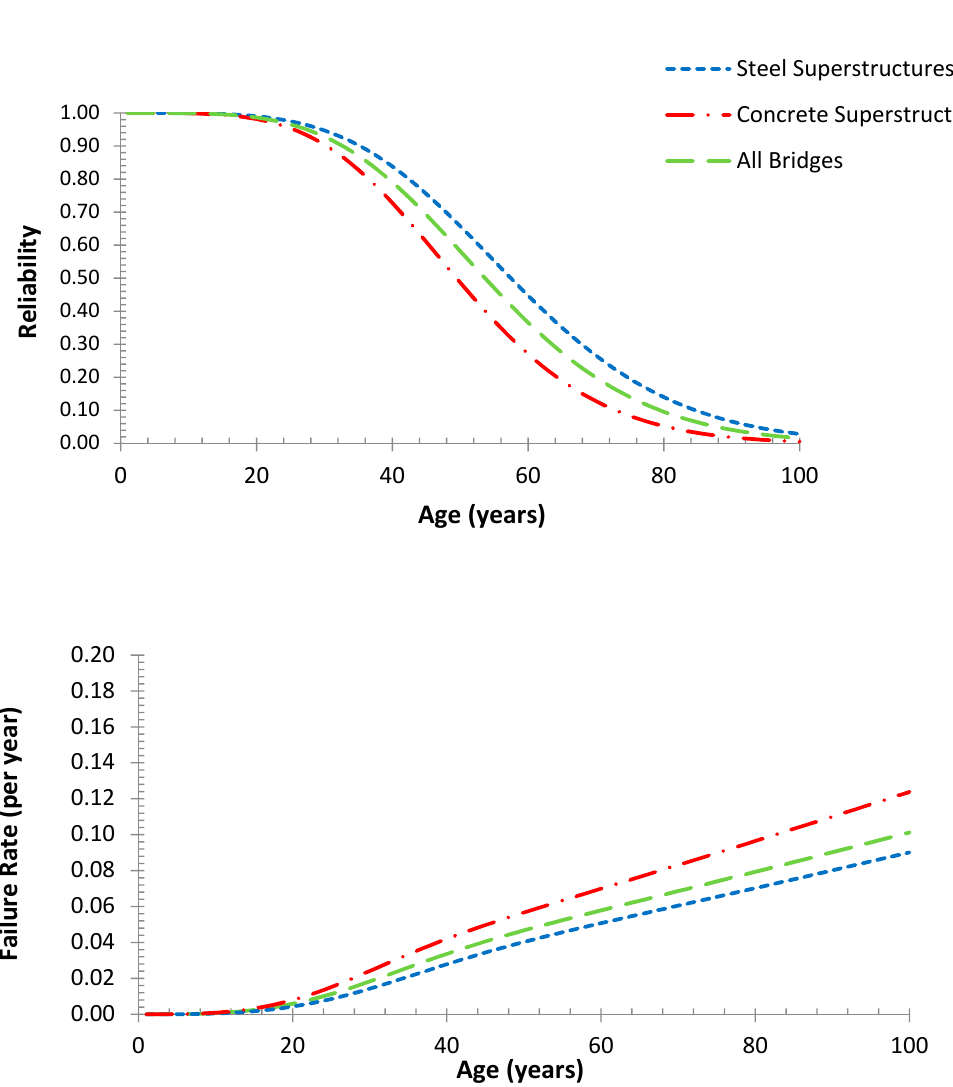
Figure 2. Hypertabastic reliability and hazard rate curves for bridge superstructures with covariates at their mean values (ADT = 4872 and MSL = 18.5 m).